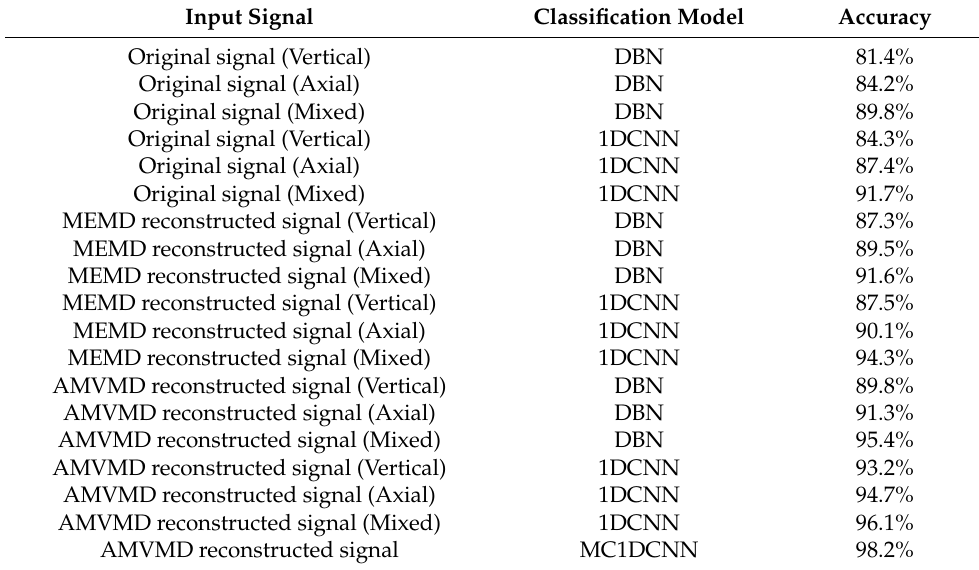
Table 4. Diagnosis accuracy of various fault diagnosis models.